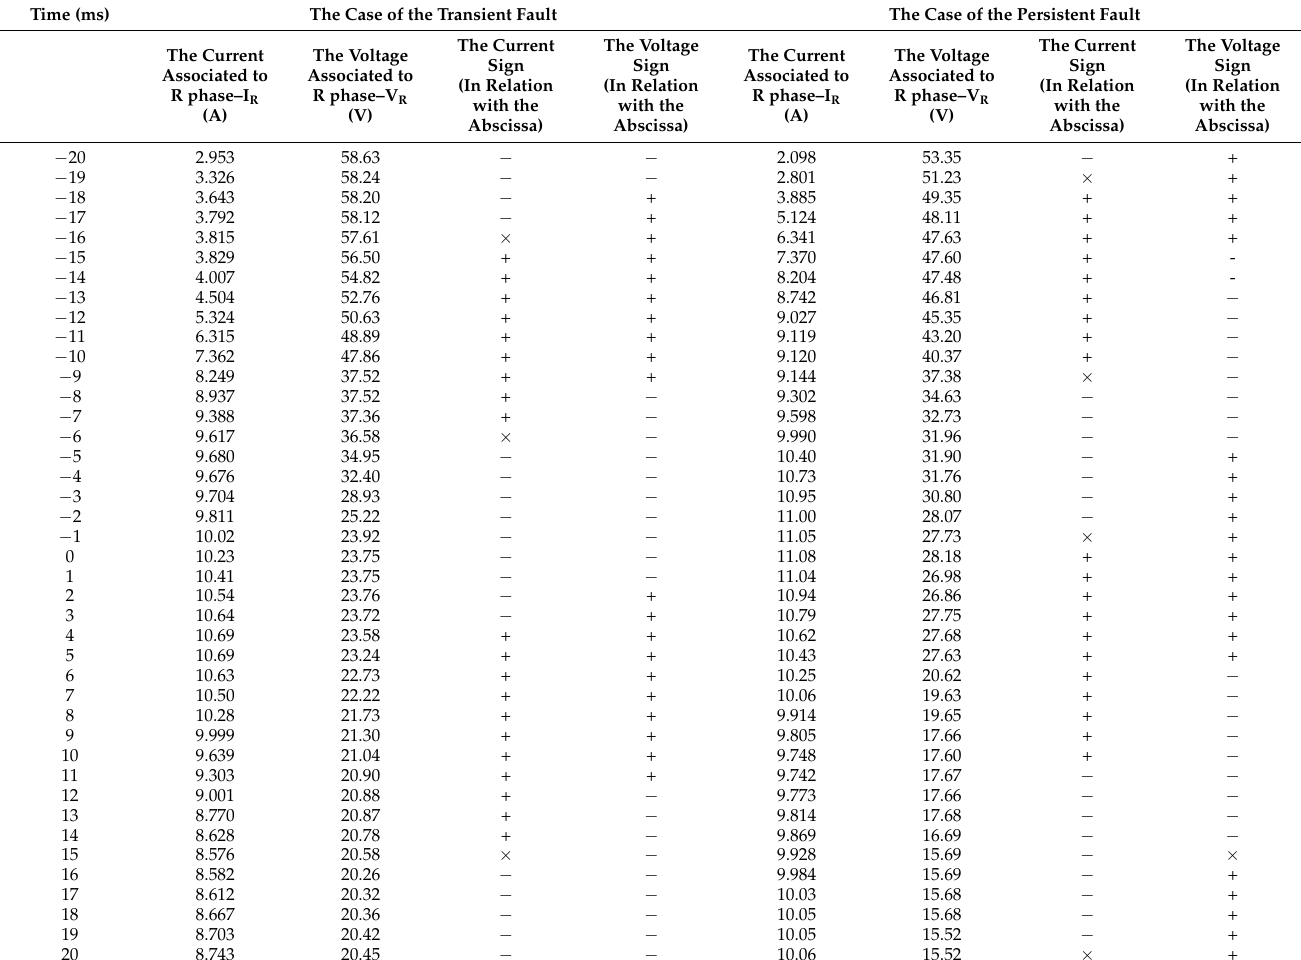
Table 1. The centralizer of the experimental